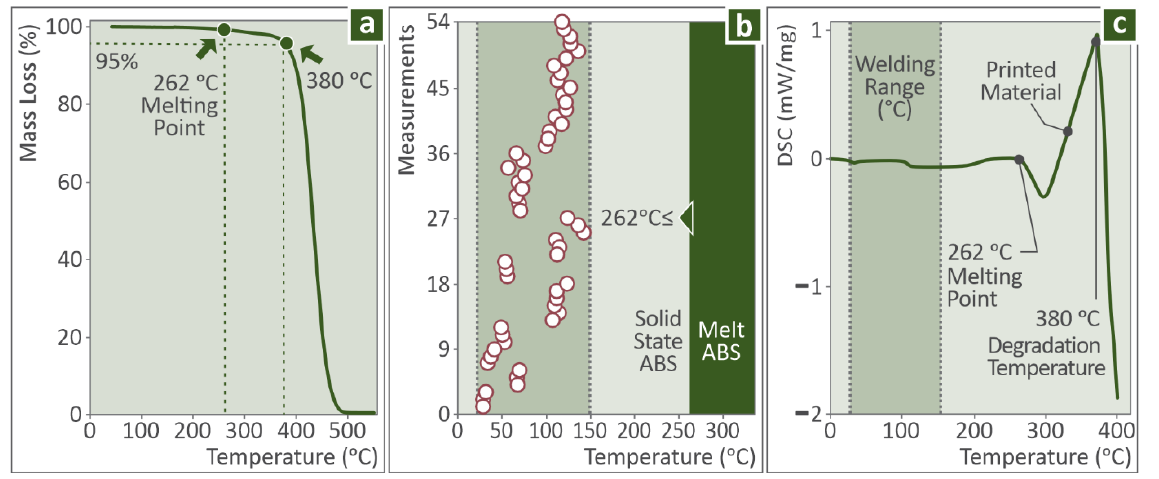
Figure 9. ( a ) TGA of the ABS, ( b ) highest temperature reported, and ( c ) DSC of the 3D printed material.